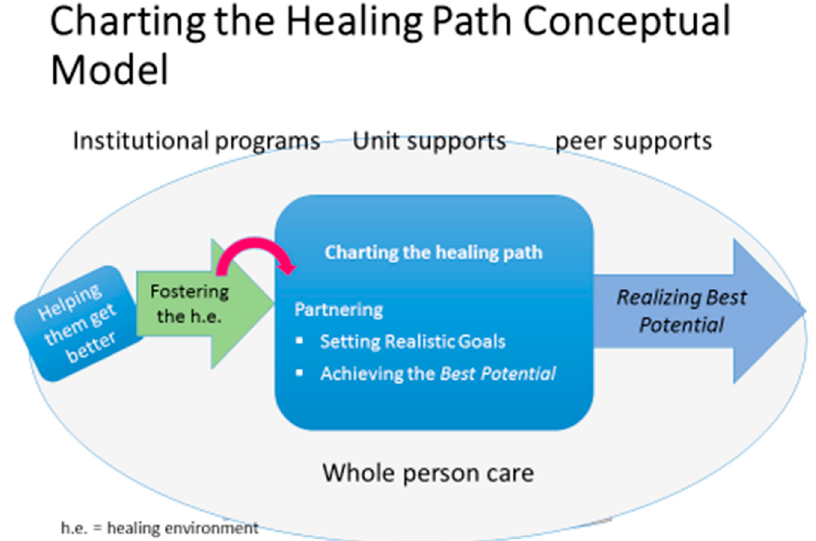
Figure 1. Charting the Healing Path Conceptual Model.